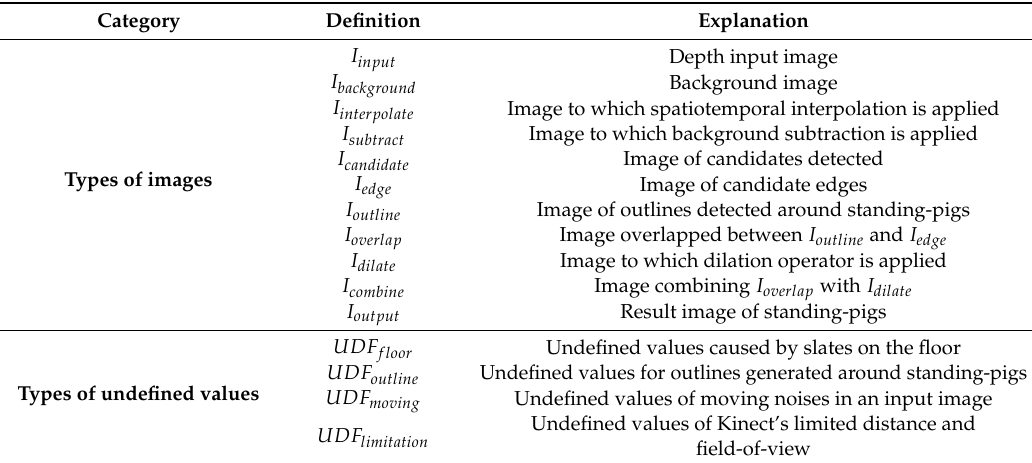
Figure 3. Overview of the proposed method. Table 2. Definition of key terms.